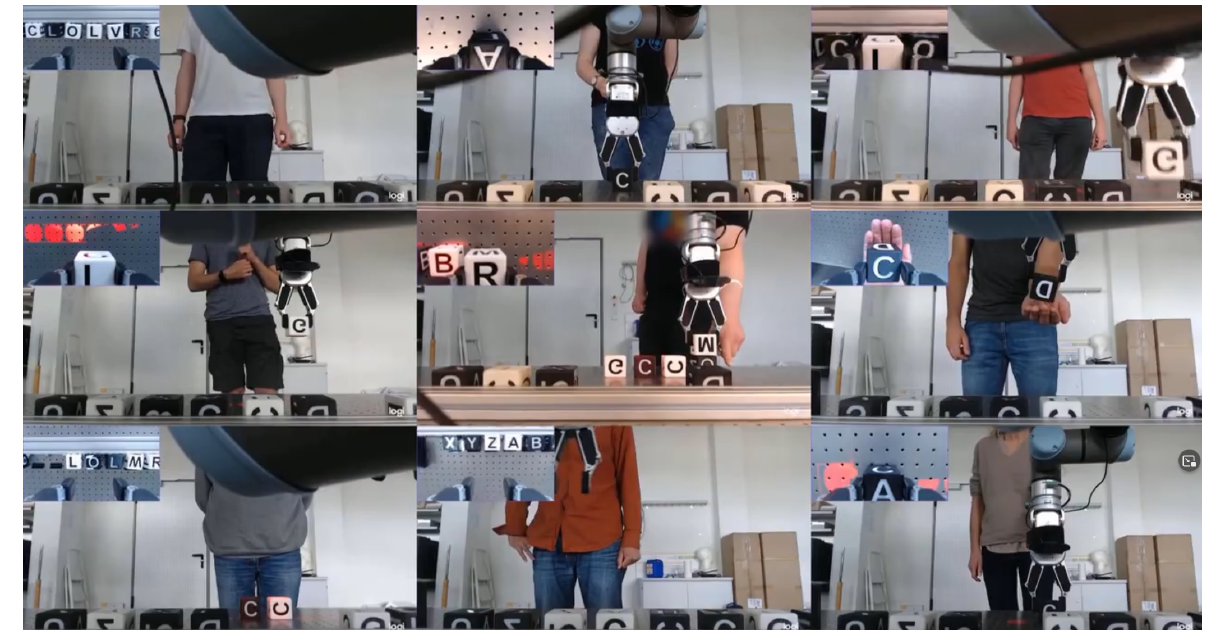
Figure 1. Previous field study Wizard-of-Oz [5]. A video summary can be found here: https: //youtu.be/JL409R7YQa0 (accessed on 29 May